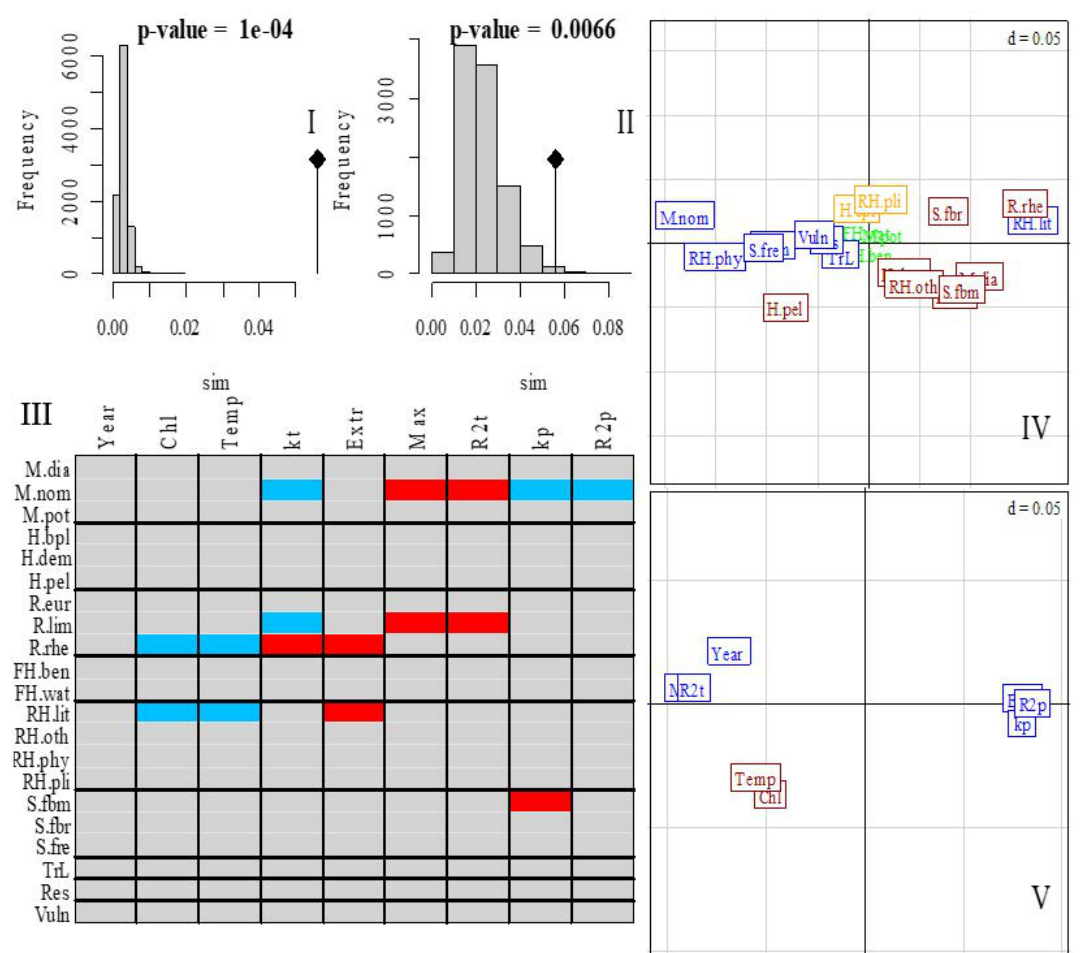
Figure 5. Results of RLQ-analysis: ( I ) is a global test of the significance of the relationship between species traits and environmental properties based on model ( II ) (the histogram shows the distribution of simulated values of total inertia (sim) for the permuted values of sites compared to the observed value of total inertia), ( II ) is a test of the global significance of the relationship between species traits and environmental properties based on model ( IV ), ( III ) is fourth-corner analysis with 999 permu- tations, which demonstrates the pairwise correlations between species traits and environmental variables. The p -values were adjusted for multiple comparisons using the false discovery rate. The gray cells indicate no statistically significant correlation, the red cells indicate positive correlations, and the blue cells indicate negative correlations significant for p < 0.05, ( IV ) is the correlation of species traits and RLQ axes 1 and 2, ( V ) is the correlation of environmental properties and habitat types and RLQ axes 1 and 2. The green color indicates no correlation, the blue color indicates a statistically significant correlation with axis 1, the orange color indicates a significant correlation with axis 2, and the dark red color indicates a significant correlation with both axes. Migration—pot are potamodromous, dia are diadromous, and nom are no migration fish species; habitat preference—pel are pelagic, bpl are benthopelagic, and dem are demersal fish species; water velocity preferences—rhe are rheophilic, lim are limnophilic, and eur are eurytopic fish species; preferred feeding habitat—wc are water column, ben are benthic fish species, reproduction habitat—lit are lithophilic, phy are phy- tophilic, pli are phyto-lithophilic, spa are psammophilic, and oth are other fish species; salinity—fre are freshwater species, fbr are freshwater-brackish species, fbm are brackish-marine